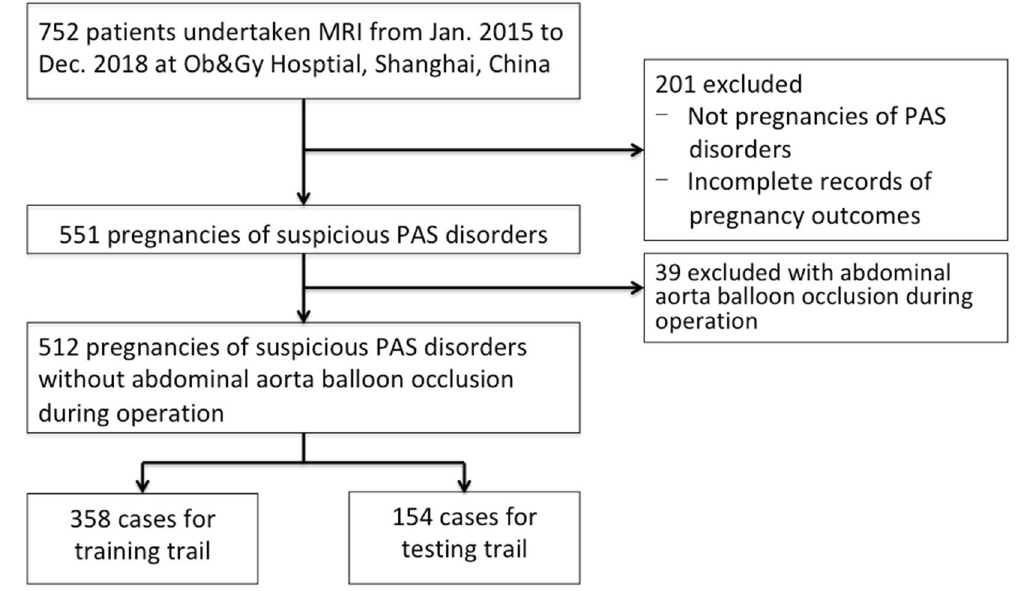
Figure 1. The flowchart of the recruited samples in this study.